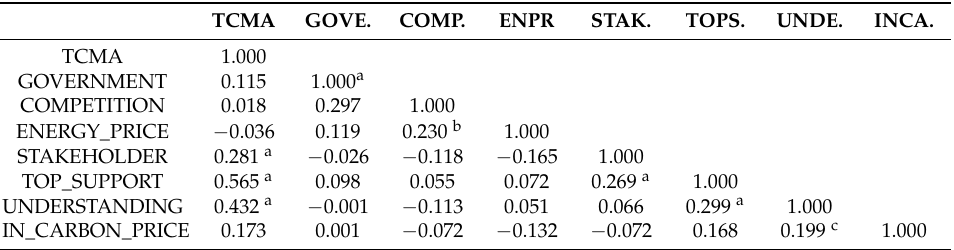
Table 7. Correlation matrix and bi-variable